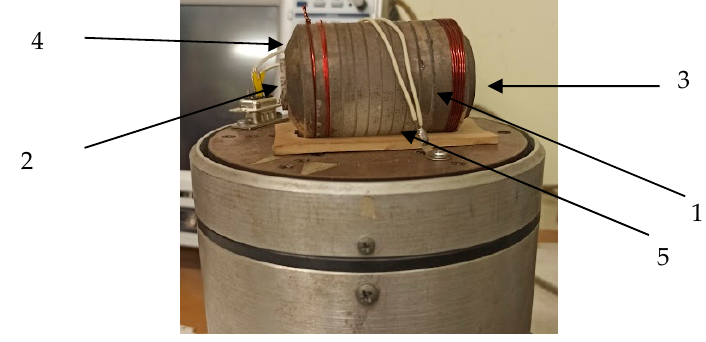
Figure 7. The SE test model.